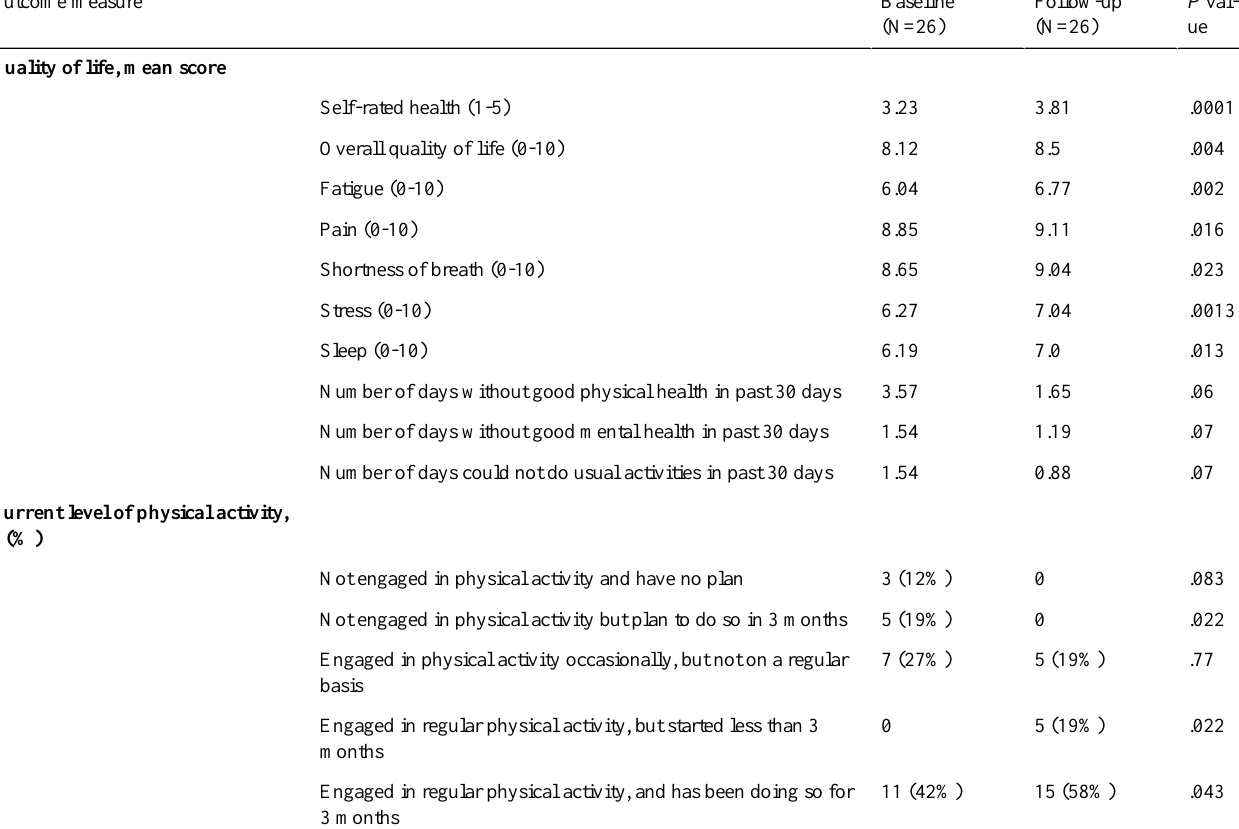
P val- ueFollow-up (N=26)Baseline (N=26)Outcome measure